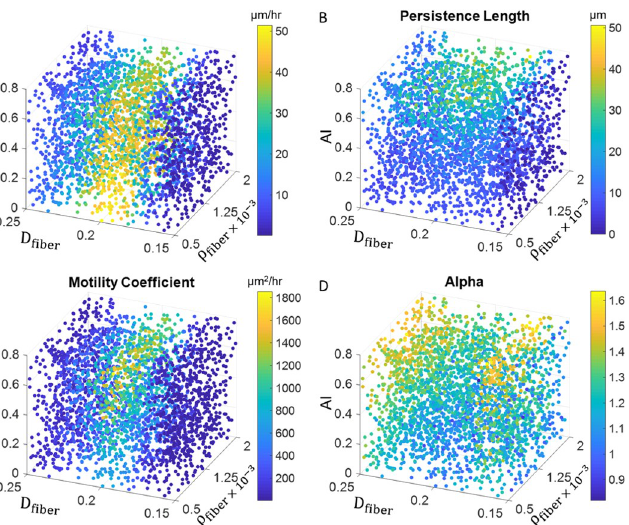
Fig 6. Combined effect of fiber alignment, fiber density, and fiber diameter. A) combined effect on cell speed B) combined effect on persistence length C) combined effect on random motility coefficient D) combined effect on alpha. Color bars show corresponding value for each parameter. Each point is the average of 10 separate